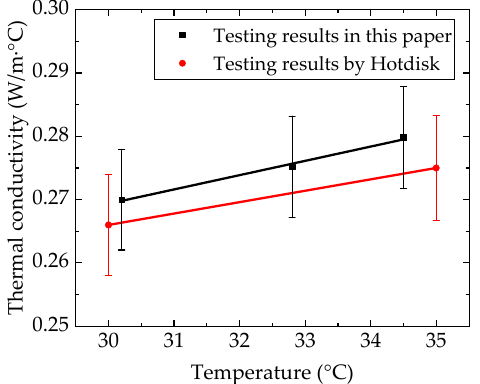
Figure 9. Thermal conductivities of n-docosane at different temperatures.